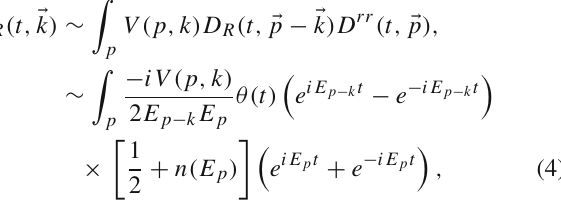
Fig. 1 Analyticstructureoftheretardedenergymomentumcorrelation function in the shear channel G 0 x , 0 x (ω, k ) in the complex frequency plane ω for the kinetic theory (1). The parts of the cut marked with red crosses correspond to medium constituent particles with lifetimes longer than the hydrodynamical decay time and will eventually domi- nate the correlation function at late times. The upper complex half plane is analytic by causality whereas for | Re ω | > k the correlation function is analytic by locality of the scattering kernel. The nonanalytic features of the function are confined to the grey